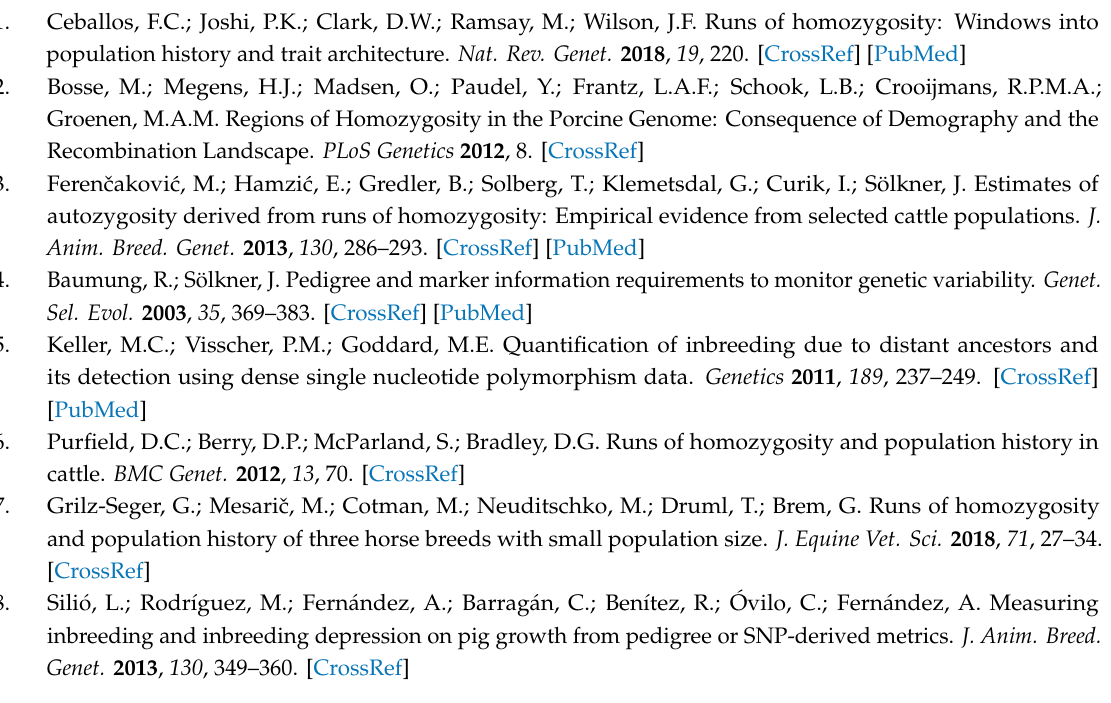
Table S1: Candidate genes within ROH hotspots. Figure S1. The mean sum of runs of homozygosity (ROH) per animal estimated within four di ff erent generation categories. ROH were mapped according to their genetic positions. ROH length within each category was calculated using 100 / 2 g, replacing g with the number of generations of